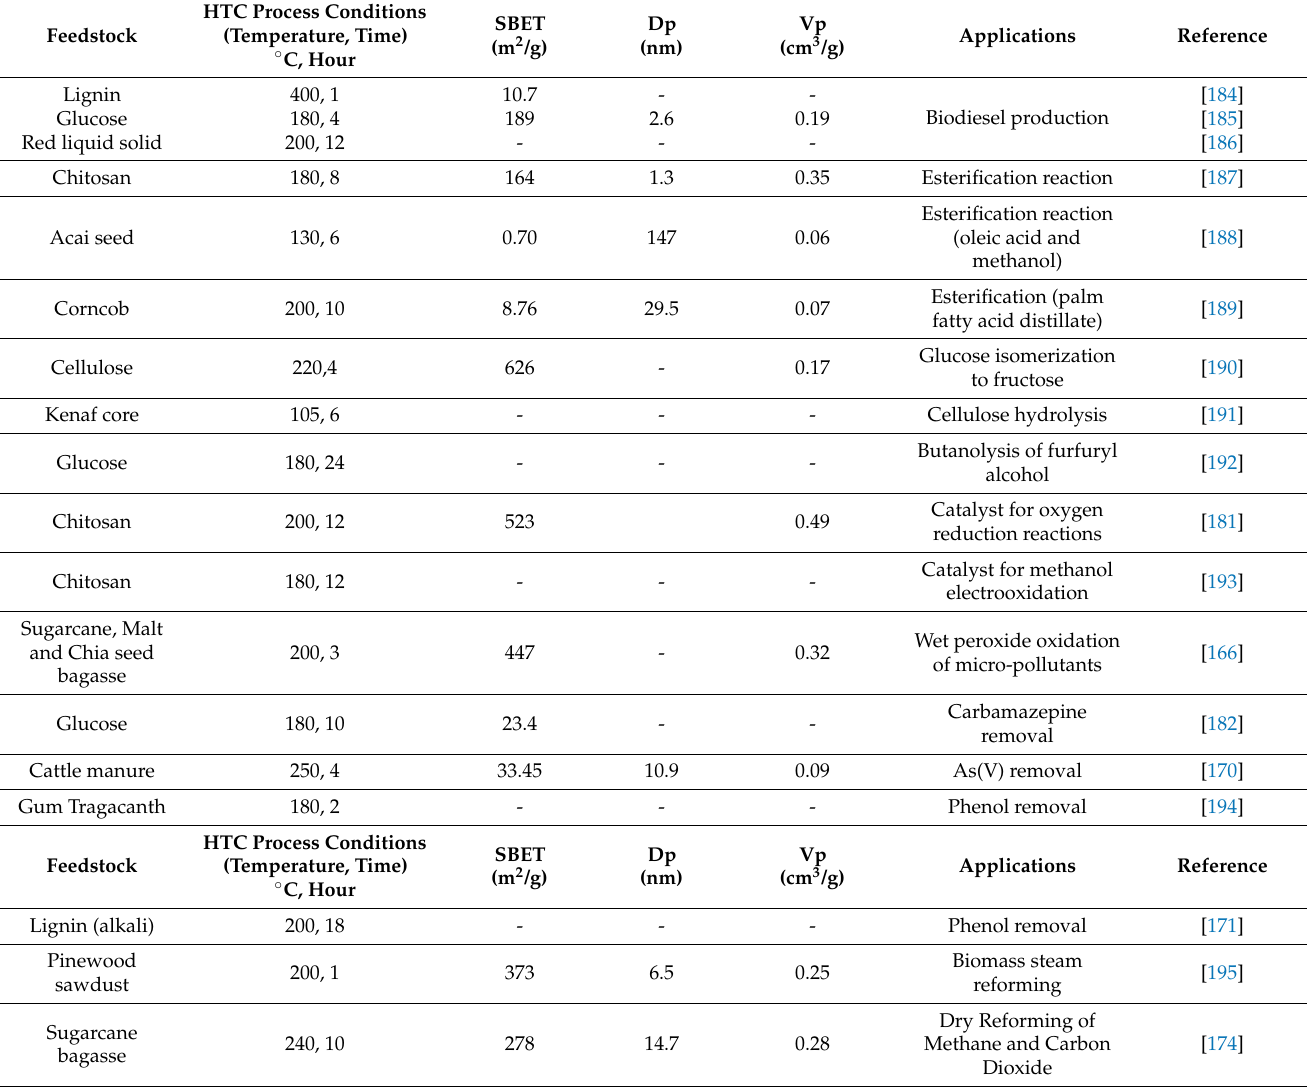
Table 6. Hydrochar as catalyst